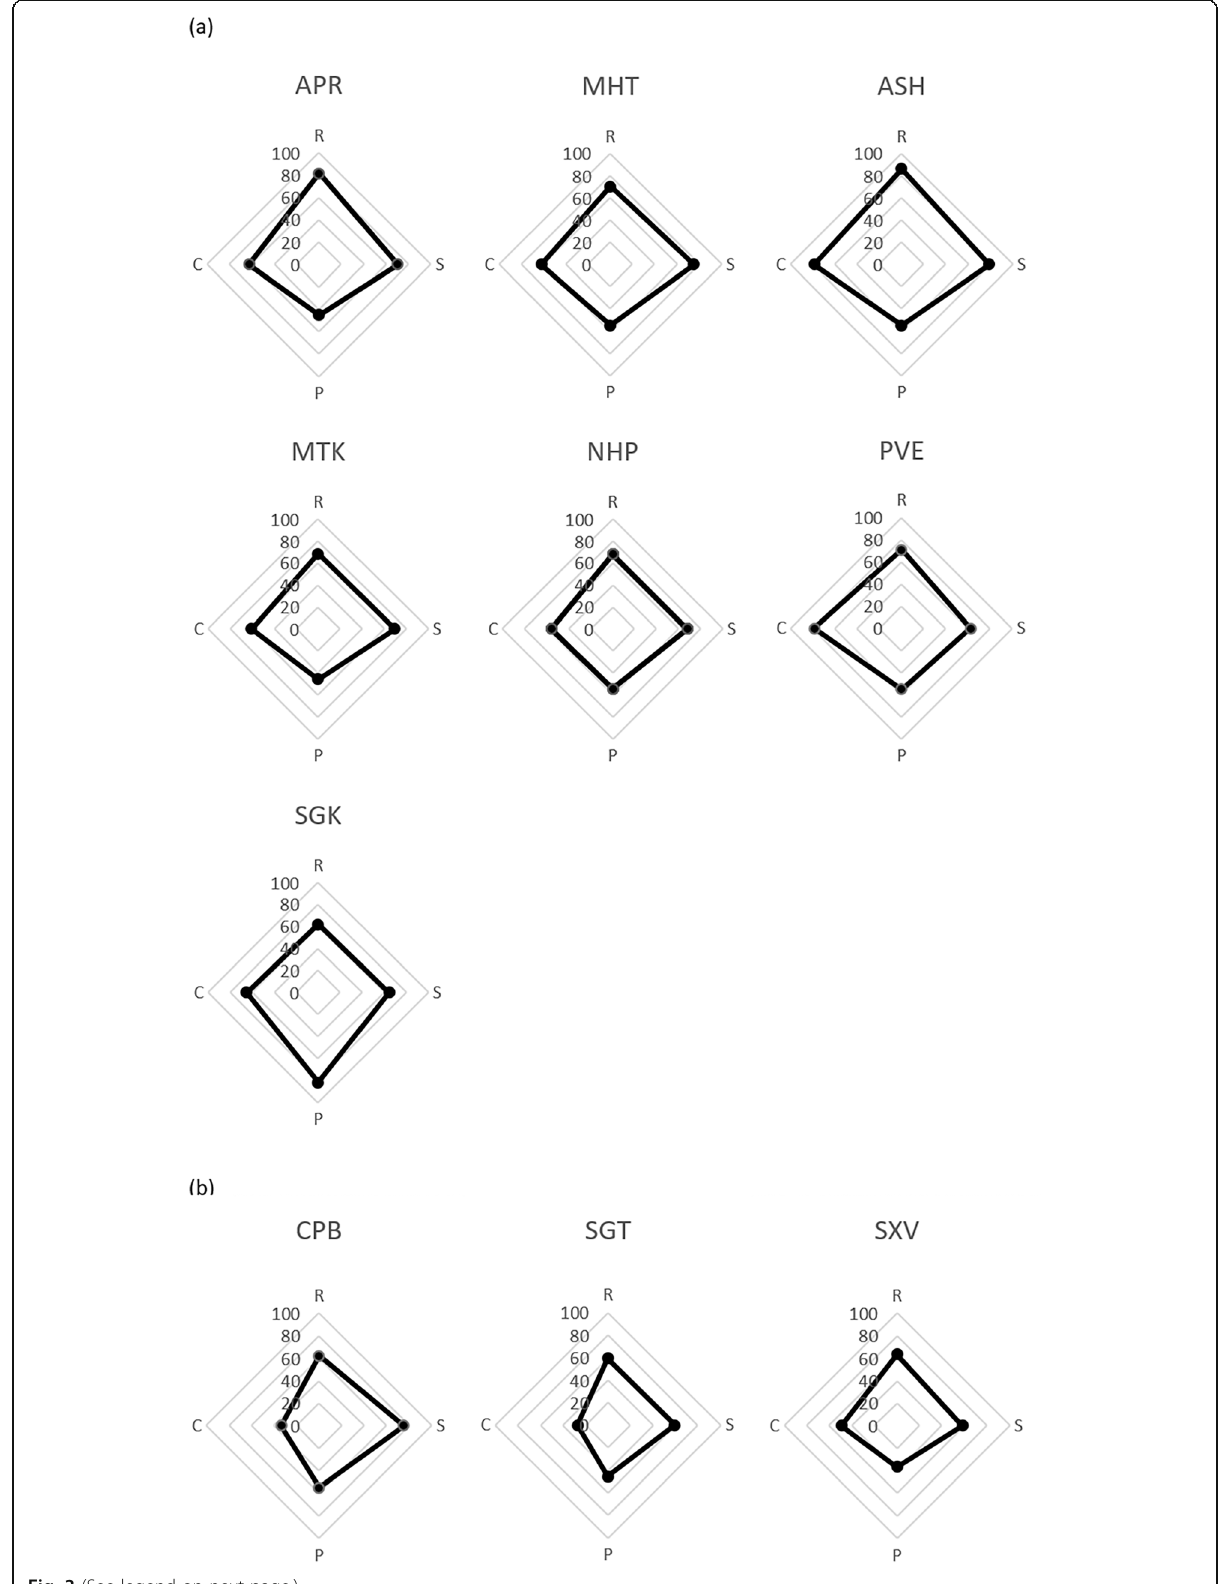
Fig. 3 (See legend on next